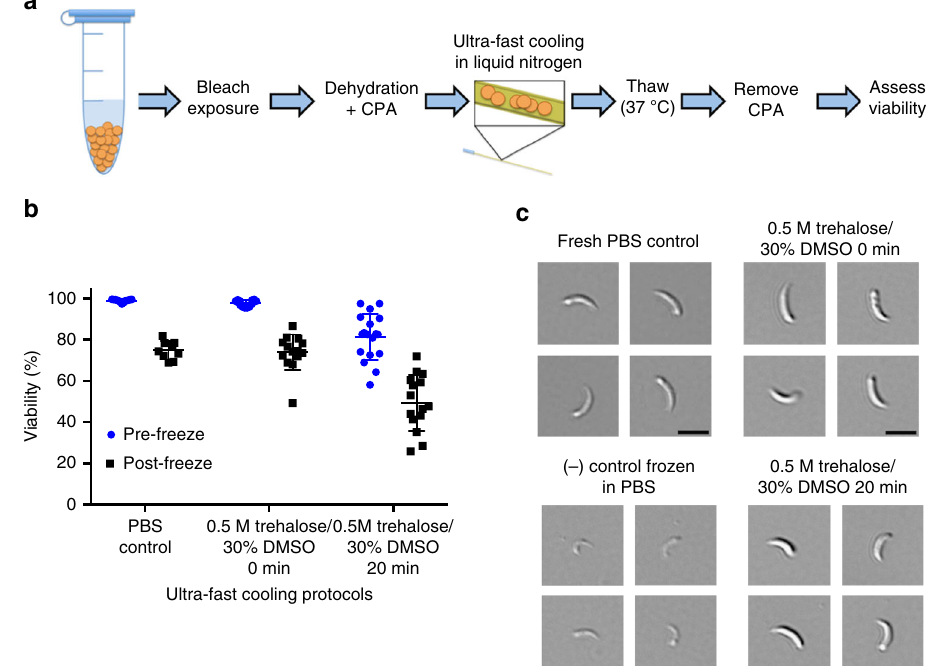
Fig. 2 Vitri fi ed C. parvum oocysts are viable and excyst. a To ensure vitri fi cation, bleached oocysts were dehydrated in 1 M trehalose and then suspended in 0.5 M trehalose/30% DMSO. Oocysts were then immediately loaded into microcapillaries and plunged into liquid nitrogen for 5 min, or incubated with CPA solution for 20 min followed by loading of microcapillaries and freezing. Oocysts were thawed by quickly transferring the microcapillary from liquid nitrogen to a 37 °C water bath. Viability was quanti fi ed after CPA removal based on PI exclusion and quality of excysted sporozoites. b Oocyst viability was determined by PI exclusion, both pre-freeze and after cryogenic storage. Values indicate means and error bars indicate standard deviation ( n = 12). c DIC micrographs show excysted sporozoites. Sporozoite viability was assessed on basis of their shape, structure and observed motility after excystation in 0.75% taurocholic acid at 37 °C. Scale indicates 5 µ